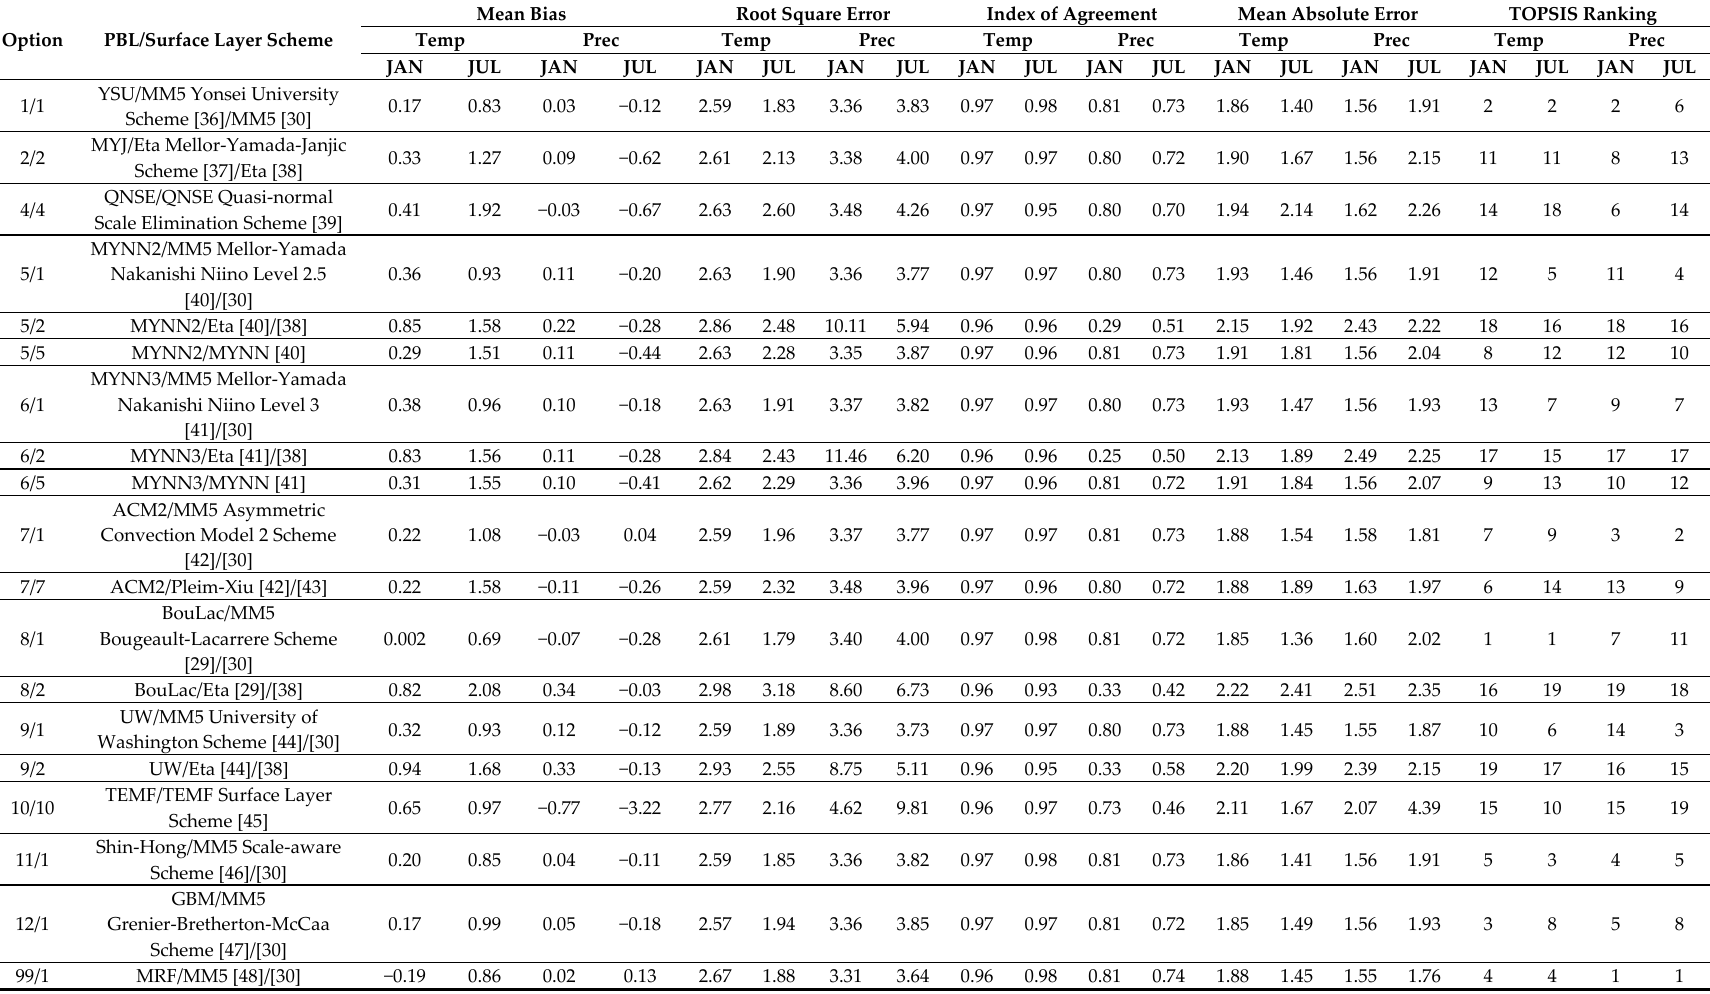
Table 3. Statistical measures and TOPSIS ranking for the PBL/Surface Layer simulation